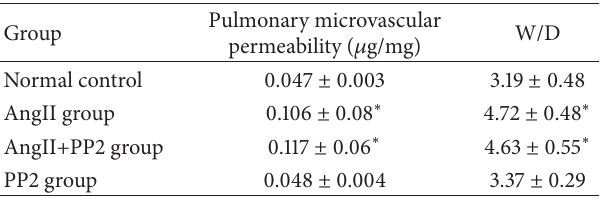
Table 2: Determination of pulmonary microvascular permeability and W/D in each